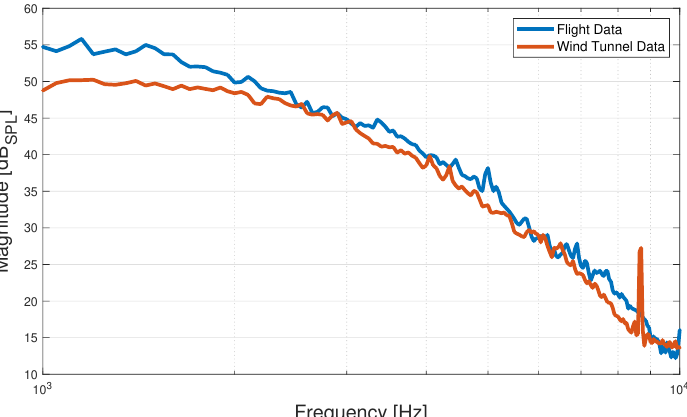
Figure 8. PSDs of wind tunnel and flight data segments for the subtracted microphones signals at an airspeed of 12 m/s, computed using Welch’s method. The wind tunnel data segment corresponds to an AoA of 0 ◦ and UAV motor configuration R